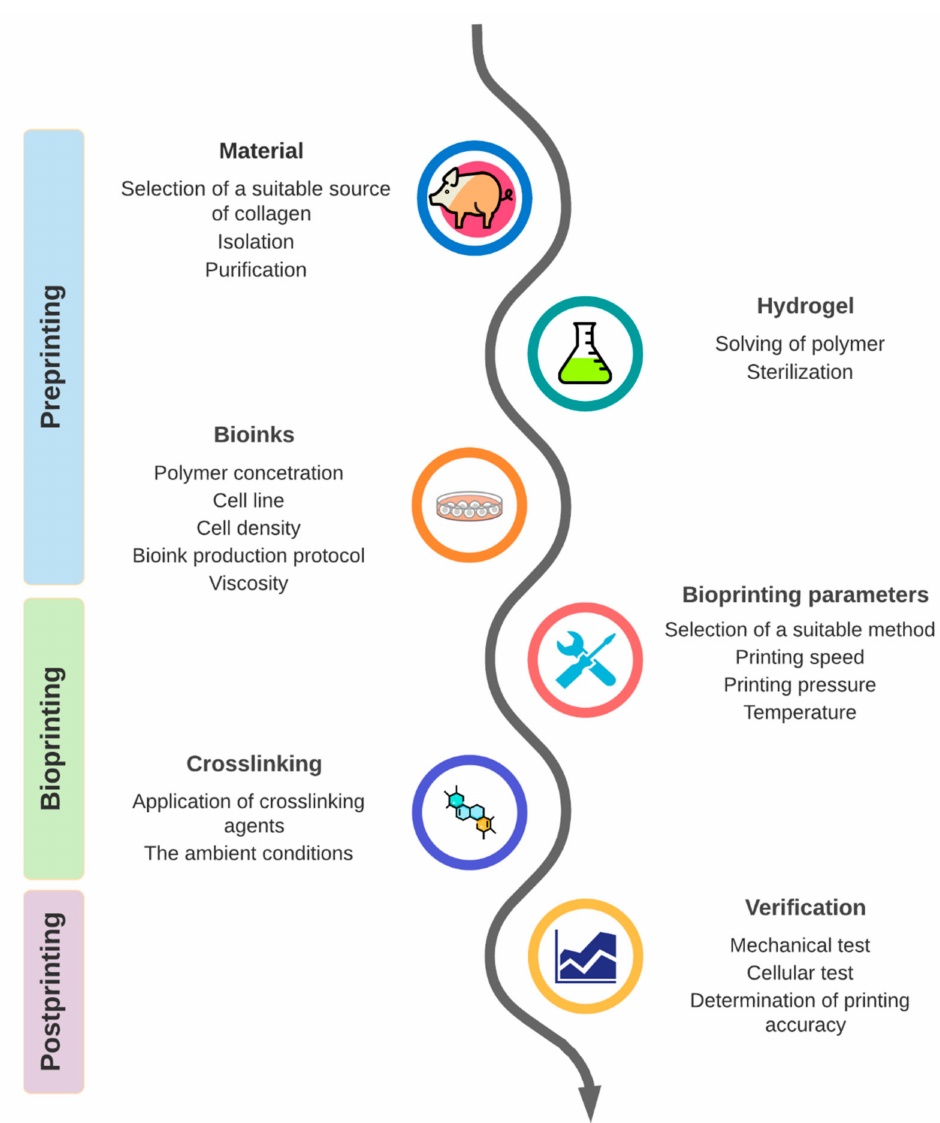
Figure 1. Design and phases of the bioprinting